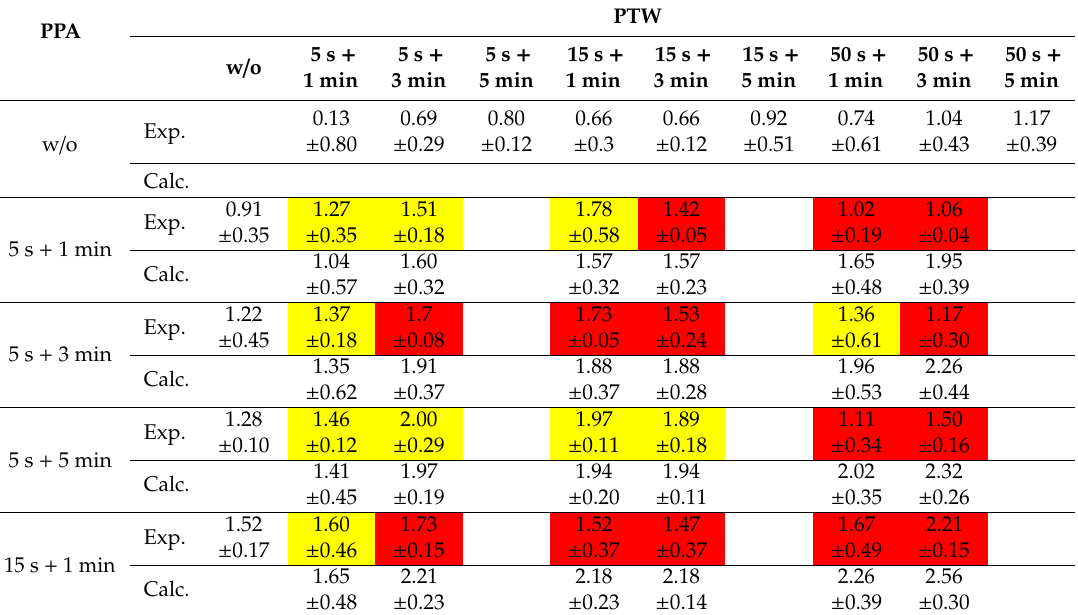
Table 1. Experimental ( (cid:102) RF comb ) and calculated (cid:102) RF add data of the single and combined applications of PPA (plasma-processed air) and PTW (plasma-treated water) under different pre- and post-treatment times for antimicrobial effects on Candida albicans SC5314. Color code for effects of combined PTW / PPA treatments: red = antagonistic, yellow = additive, green = synergistic. w / o = without. Exp. = experimental, Calc. =